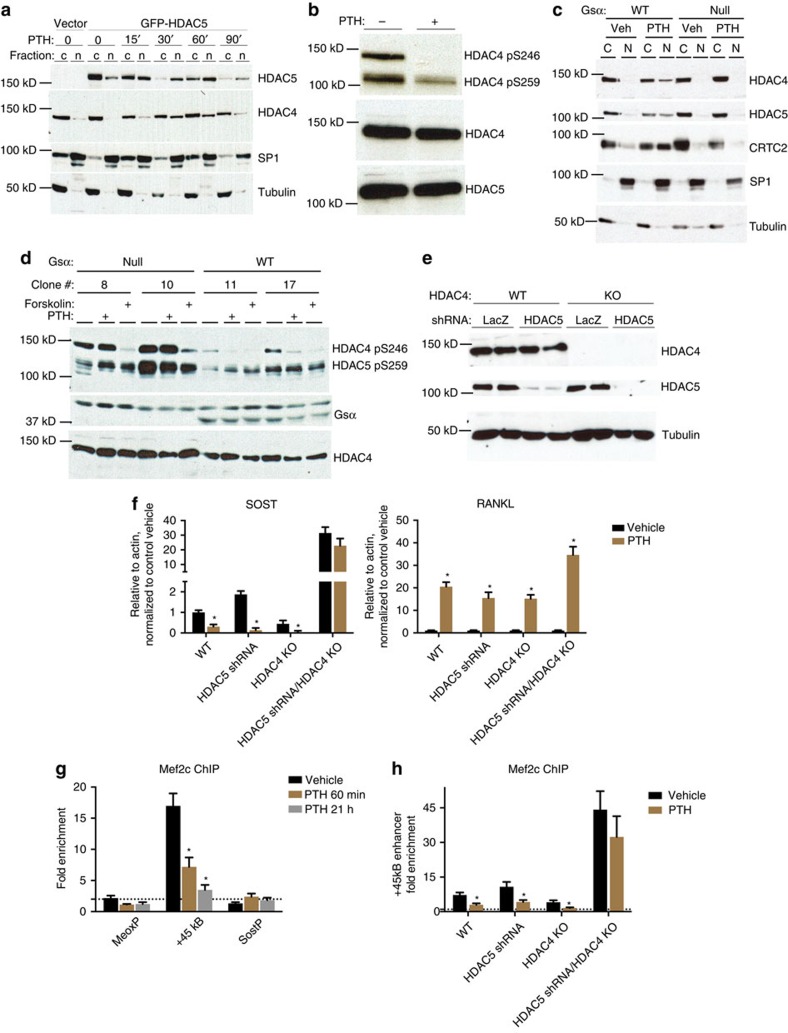
Class IIa HDACs are required for PTH-induced SOST suppression in vitro.(a) Ocy454 cells were transfected with GFP-HDAC5 and then treated with PTH (50 nM) for the indicated times. Cytosolic (c) and nuclear (n) lysates were prepared and immunoblotted as indicated. (b) Ocy454 cells were treated with PTH (50 nM) for 30 min. Whole cell lysates were prepared and immunoblotted as indicated. Similar results were observed in four independent experiments. (c) Ocy454 cells with (WT, clone 17) and without (Null, clone 8) Gsα were treated with PTH (50 nM for 30 min) and analysed as in (a). (d) Ocy454 cells with (WT) and without (Null) Gsα were treated with either PTH (50 nM) or forskolin (5 μg ml−1) for 30 min and analysed as in b. (e) Ocy454 cells were exposed to the indicated combinations of HDAC4-targeting sgRNAs (with Cas9) and HDAC5 shRNA-expressing lentiviruses, and whole cell lysates were analysed by immunoblotting as indicated. (f) WT, HDAC5 shRNA, HDAC4 KO and DKO Ocy454 cells were treated with PTH (1 nM) for 4 h, and SOST (left) and RANKL (right) mRNA transcript abundance was measured by RT-qPCR. For all cell culture experiments therein, values represent mean of n=3 biologic replicates. *indicates P<0.05 comparing the effects of PTH to vehicle for each cell line. Error bars represent SEM. (g,h) MEF2C chromatin immunoprecipitation was performed, and enrichment for the +45 kB enhancer determined (relative to control IgG ChIP). *indicates P<0.05 comparing fold enrichment of PTH versus vehicle by student's unpaired two tailed t-test.